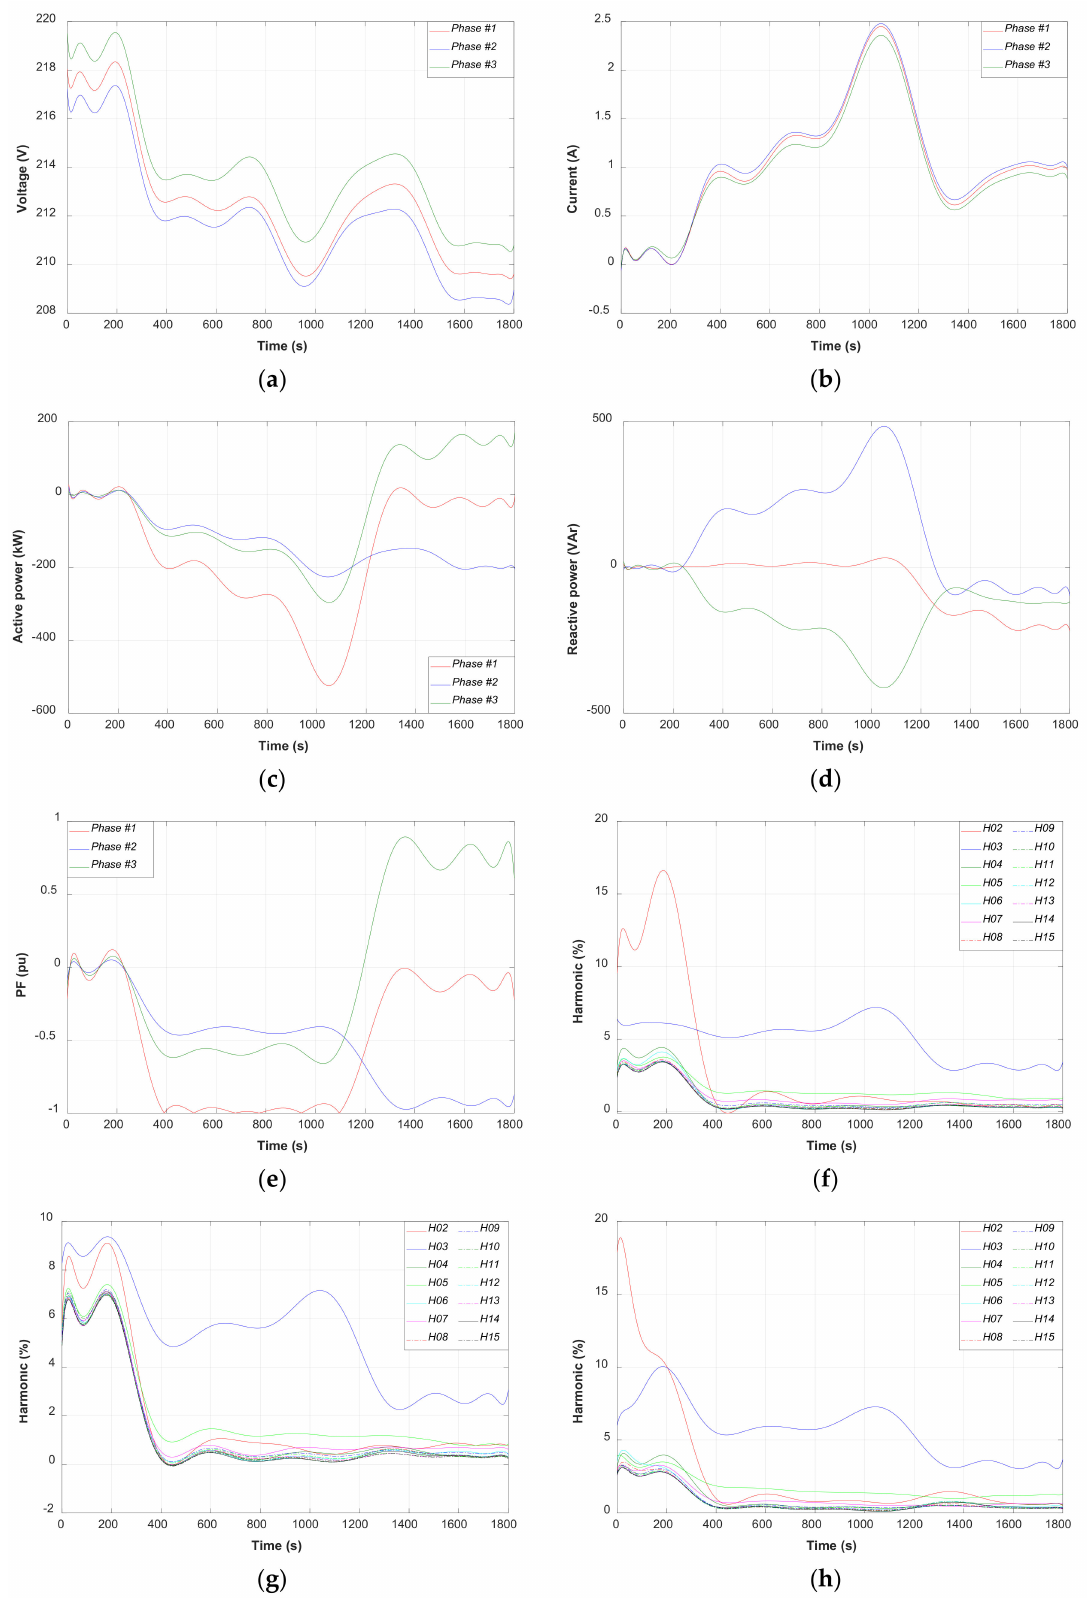
Figure 18. Measured data per phase for a synchronous generator feeding a three-phase load: ( a ) voltages; ( b ) currents; ( c ) active powers; ( d ) reactive powers; ( e ) power factor; ( f ) Phase #1 current harmonics; ( g ) Phase #2 current harmonics; and ( h ) Phase #3 current